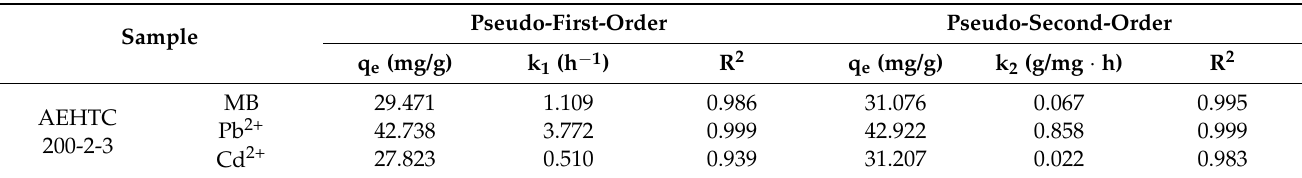
Figure 6. Adsorption experimental (symbols) and fitting (lines) kinetics curves of MB ( a , b ), Pb 2+ ( c , d ), Cd 2+ ( e , f ) on AE-CMIW hydrochar in mixed solution. Table 3. Adsorption kinetics parameters of MB, Pb 2+ , Cd 2+ on AE-CMIW hydrochar in mixed